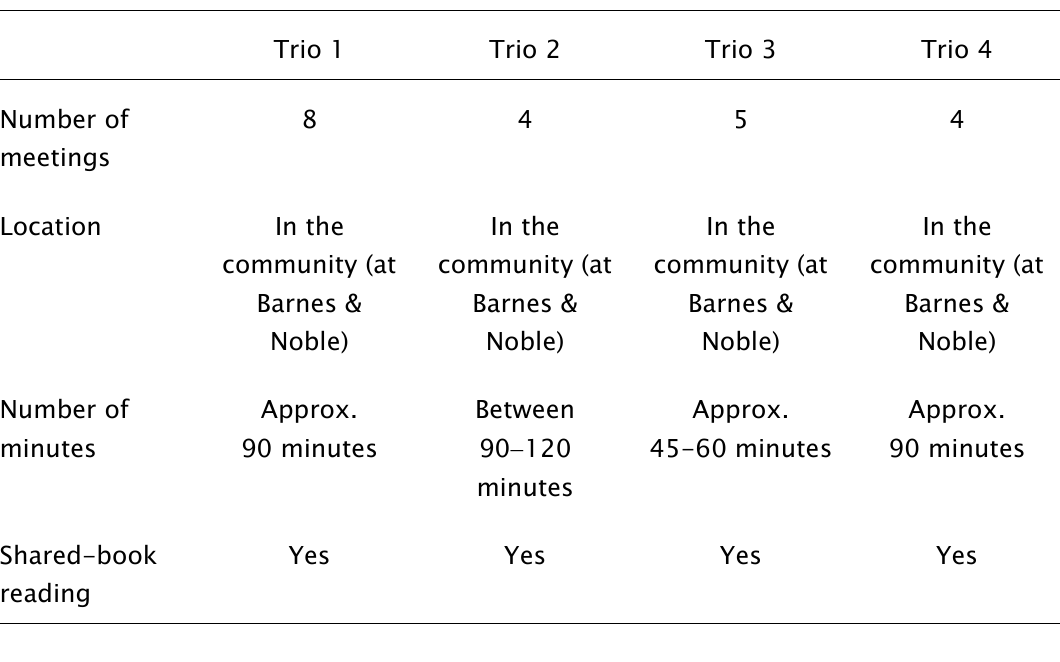
Summary of the Four